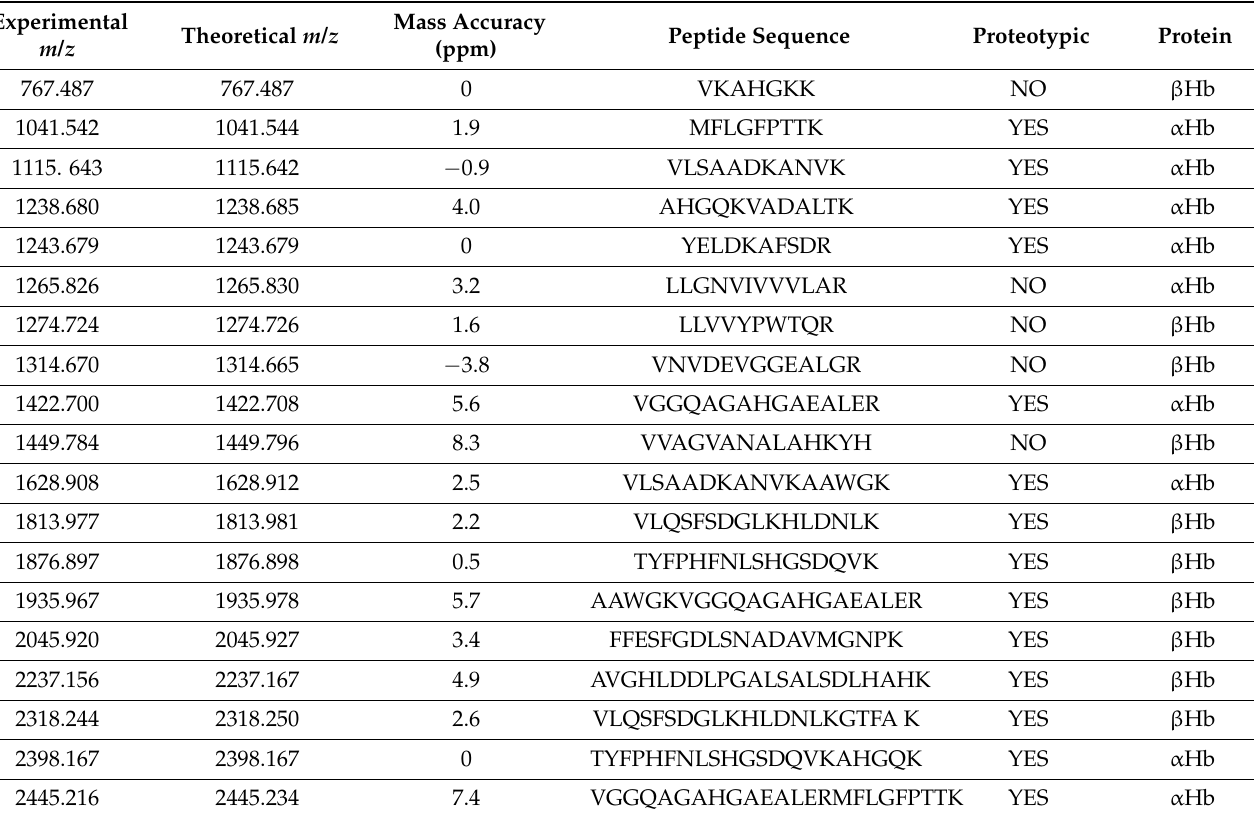
Table 2. Putatively identified peptides from the MALDI MS spectra of proteolysed porcine intra- venous